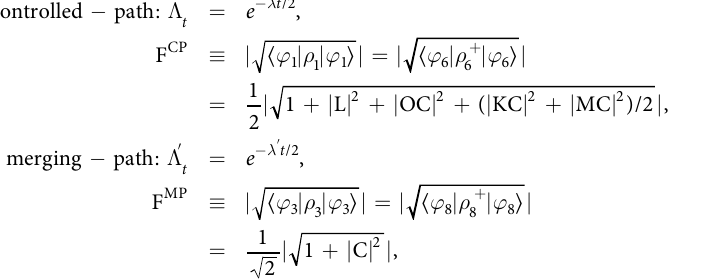
Figure 7. Big (small) diagram represents the density matrix, ρ 1 or ρ + to the process model in Eq. 20, after controlled-path (merging-path) gate. These diagrams obviously show that values of coherent parameters approach 1 and fidelities F CP (of controlled-path gate) and F CP (of merging-path gate) are increased when using strong (large amplitude) coherent state for αθ = αχ t = 2.5 and N = 10 3 with signal loss of 0.15 dB/km ( χ / λ = 0.0303) in optical fiber 71 . In the Table, fidelities and the rate of Λ remaining photon in probe beams of controlled-path gate (merging-path gate) are calculated in accordance with differences in amplitude, α , of coherent state. In addition, when αθ = αχ t = 2.5 is fixed